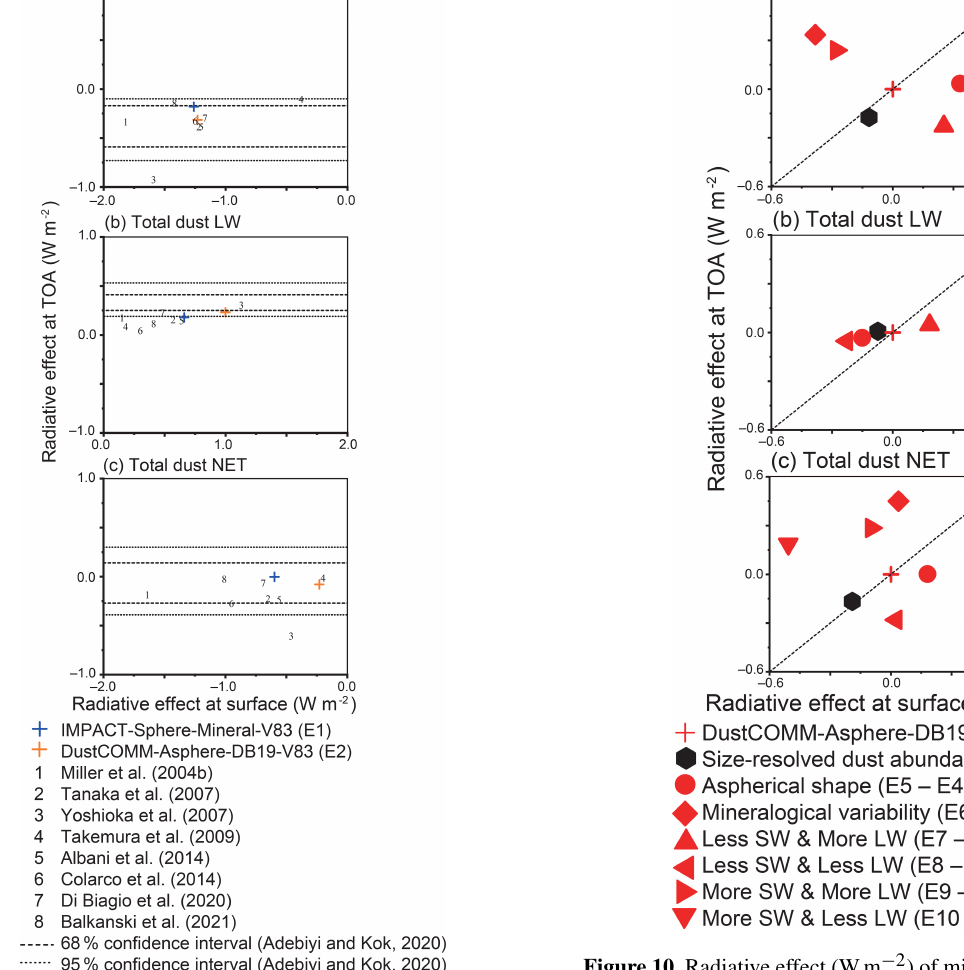
Figure 10. Radiative effect (Wm − 2 ) of mineral dust due to various aerosol absorptivity at the surface and TOA for (a) total dust SW, (b) total dust LW, and (c) total dust NET. The annually averaged values are listed in Table 5. The dashed line represents a 1 : 1 corre- spondence and corresponds to no change in radiative heating within the